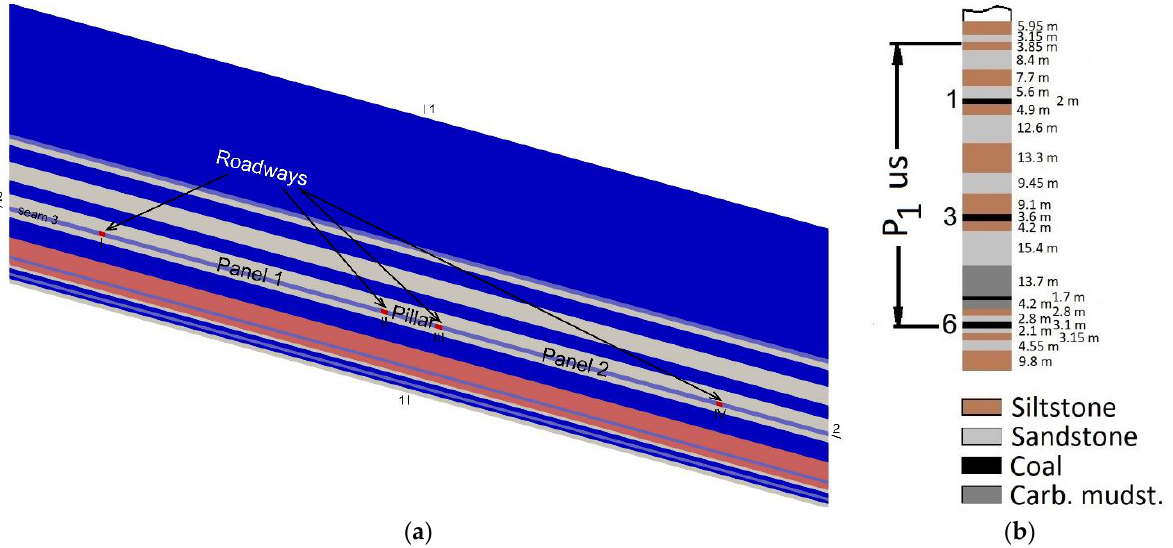
Figure 2. Central cross-section of the geomechanical model ( a ) and magnified stratigraphy ( b ) of the study site.